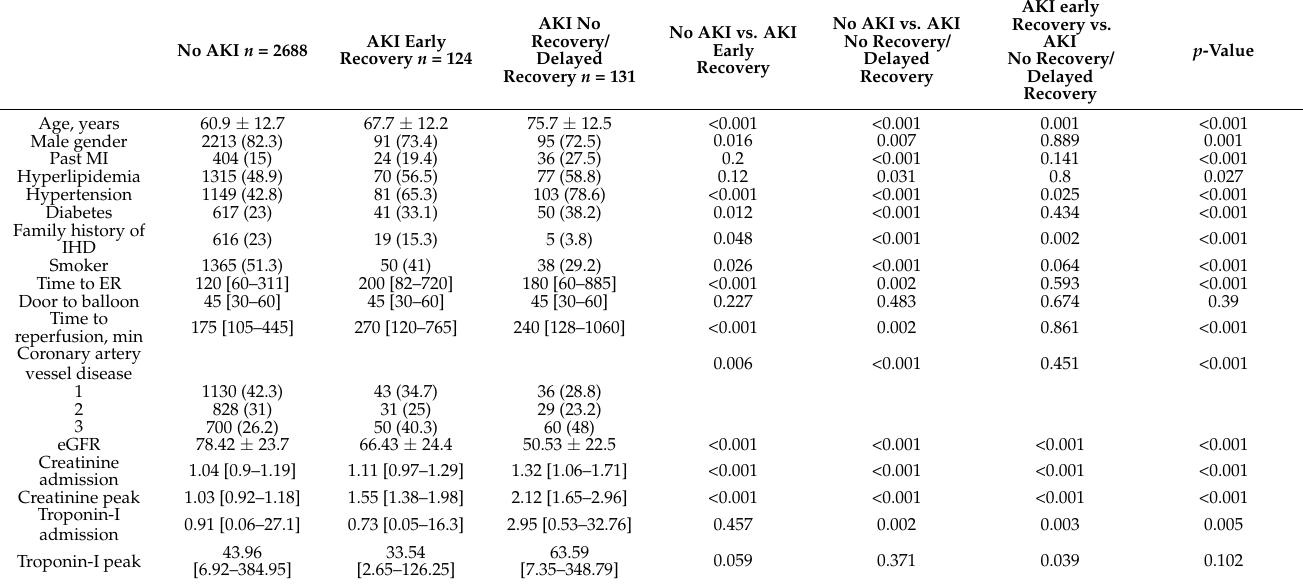
Table 1. Baseline Characteristics.